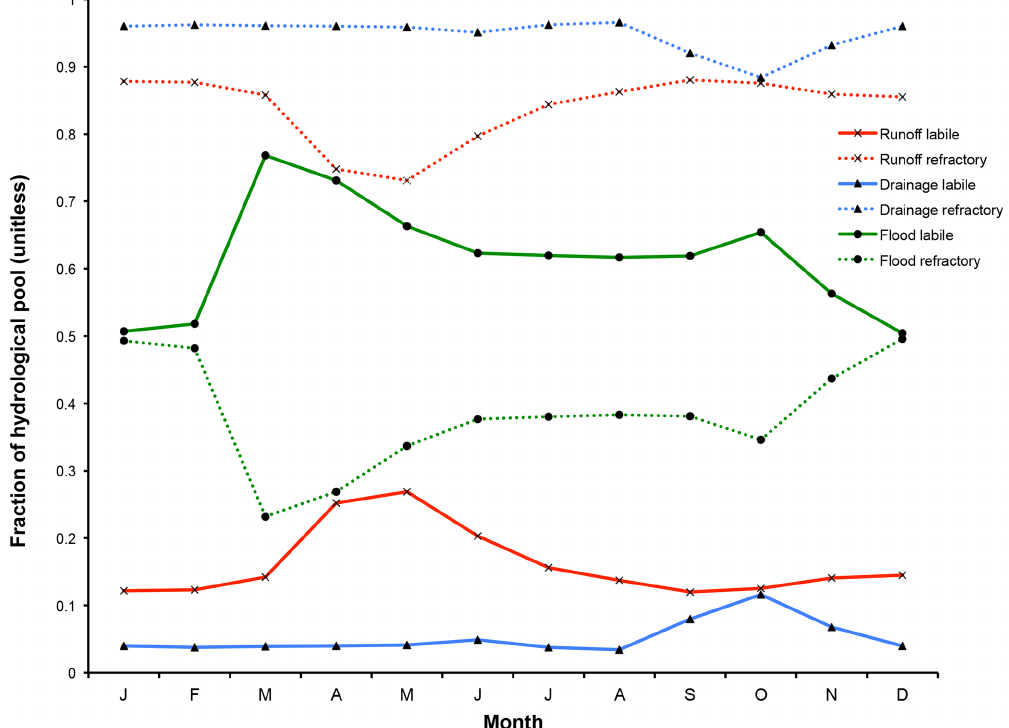
Figure 9. The mean monthly fraction of each hydrological pool’s (runoff, drainage, floodplains) carbon reactivity constituents (labile and refractory) averaged across the simulation area over 1998–2008.